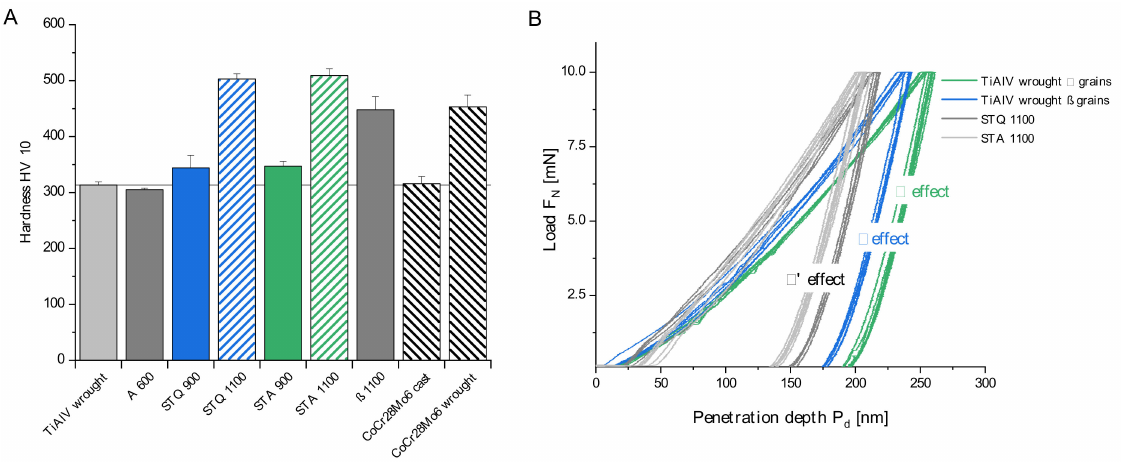
Figure 4. Mechanical properties of heat-treated TiAl6V4 alloy. ( A ) Measured macro-hardness HV10 and ( B ) load-displacement curves from nanoindentation with 10 mN of exemplary TiAl6V4 wrought